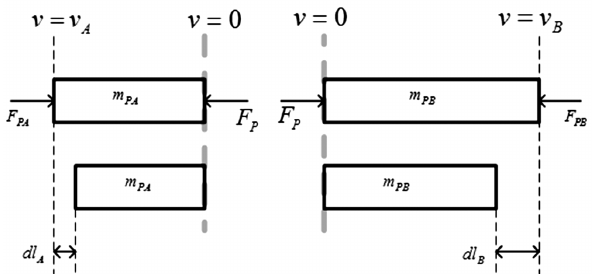
Figure 3. The free-body diagram of the PZT